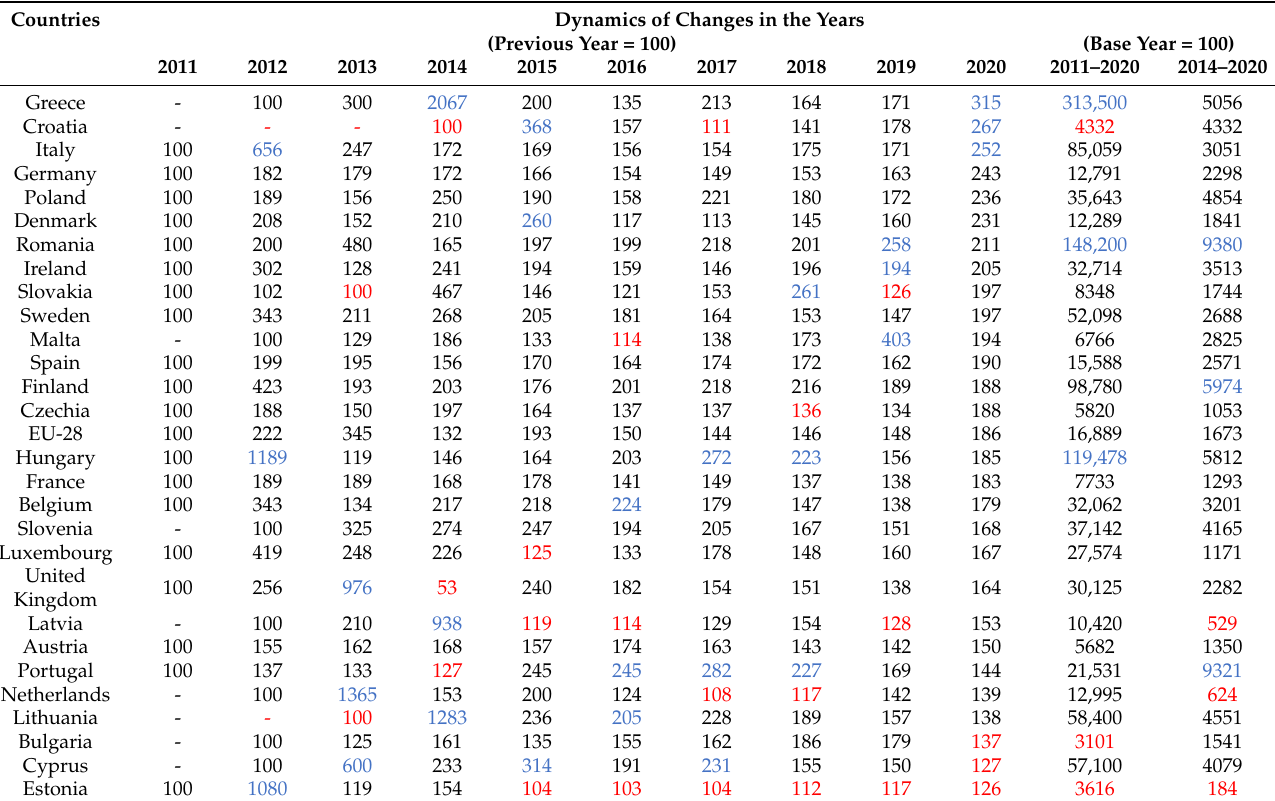
Table 3. Dynamics indicators for the number of electric cars in EU countries in 2011–2020.